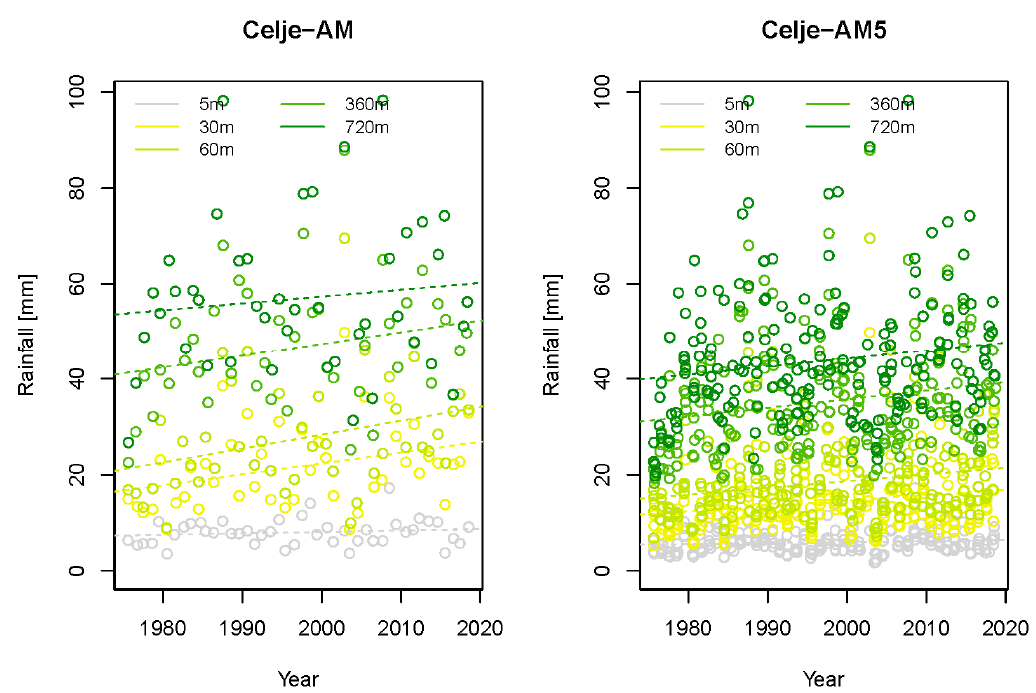
Figure 3. AM and AM5 samples for different rainfall durations (i.e., 5, 30, 60, 360, and 720 min) for the Celje station. Linear trend lines are also added to the plot.